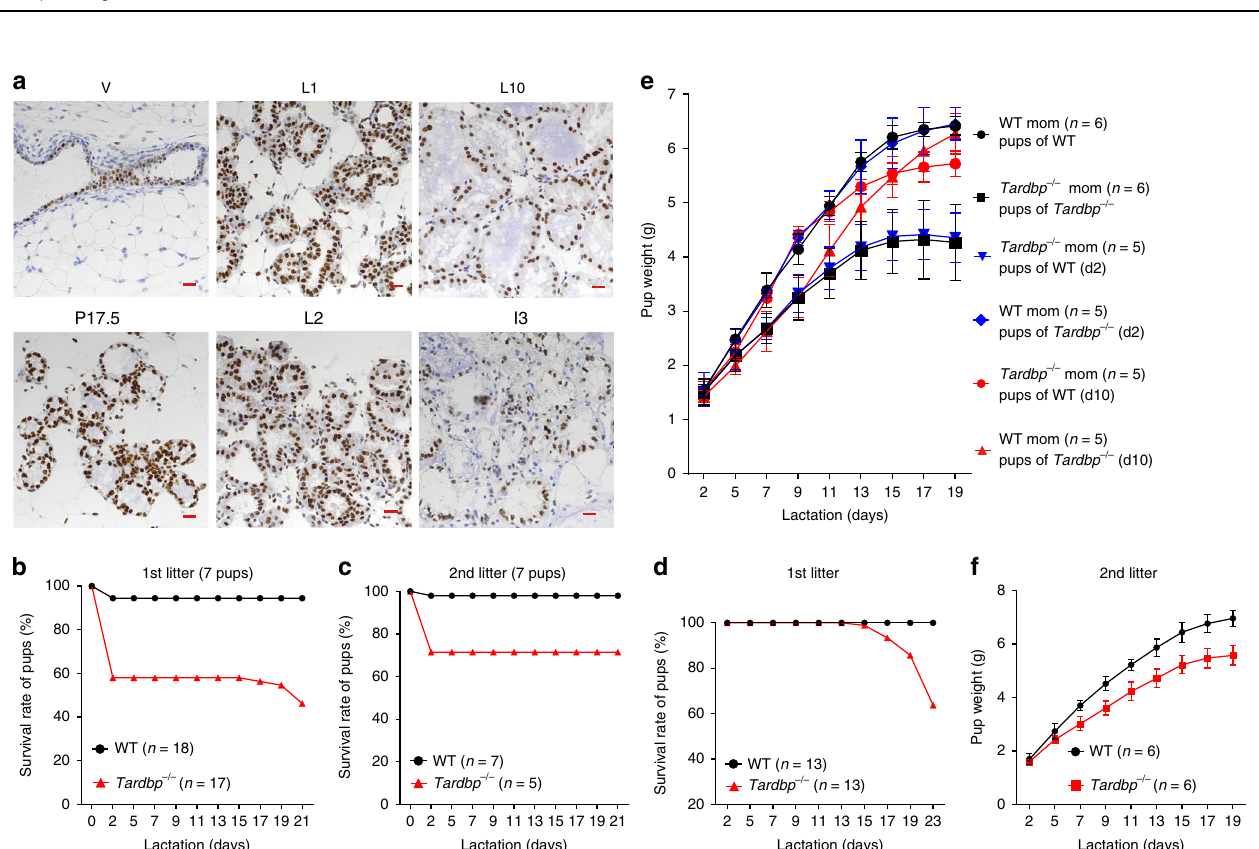
Fig. 1 TDP-43 loss induces lactation failure in mammary epithelium. a Immunohistochemical (IHC) staining of TDP-43 in mammary glands of C57BL/6 female mice at different developmental stages (V, virgin; P17.5, pregnancy day 17.5; L1, lactation day 1; L2, lactation day 2; L10, lactation day 10; I3, involution day 3). Representative images (×40 objective magni fi cation) from four mice are shown for each stage. Scale bar: 20 μ m. b , c Pup survival rates from wild-type (WT) and Tardbp − / − female mice for fi rst ( b ) and second ( c ) lactation, with seven pups per litter. WT represents Tardbp wt/wt + WAP-Cre mice. Tardbp − / − represents Tardbp fl / fl + WAP-Cre mice. n represents number of mothers. d Pup survival rates from WT and Tardbp − / − mothers after litter size was adjusted to seven for each foster mother on L2. e Body weights of surviving pups from WT and Tardbp − / − mothers. Pups nursed by their biological mother (WT or Tardbp − / − , black lines) and cross-nursed by their foster mother ( Tardbp − / − or WT) at L2 (blue lines) and L10 (red lines) were recorded for each dam with seven pups beginning at L2. f Body weights of pups from second lactation after litter size was adjusted to seven on L2. Data are means ± SD. Source data are provided as a Source Data fi le. exclude possible defects in pups, pups born to WT and Tardbp − / − these results demonstrate that maternal Tardbp − / − induced mothers were cross-fostered by Tardbp − / − and WT mothers, failure of both pup viability and growth. respectively. Results demonstrated that pups born to Tardbp − / − female mice but fostered by WT mice beginning at L2 grew with TDP-43 loss results in disrupted lipid secretion . Morphological normal body weights and survival rates, whereas pups born to WT changes were fi rst evaluated to determine the possible causes of females but fostered by Tardbp − / − mice exhibited reduced growth lactation defects in Tardbp KO mice. Mammary glands from (Fig. 1e, blue lines and Supplementary Fig. 5I). A similar reduction Tardbp − / − mice harvested at the mid-pregnancy (P15.5, P17.5) in body weight was observed when pups born to WT females were to lactation stages (L2 and L10) demonstrated no differences in fostered by Tardbp − / − females at the beginning of L10 (Fig. 1e, either lobuloalveolar structures or alveolar densities compared red lines). These results indicate that TDP-43 is required for with WT mice based on whole-mount (Supplementary Fig. 6A) lactation to support offspring survival in mice. To ensure that the and hematoxylin and eosin (H&E) staining (Supplementary observed failure of offspring growth and viability was dependent Fig. 6B). Moreover, TUNEL assay and Ki67 staining revealed on the Tardbp genotype of the mothers, rather than that of the indistinguishable rates of apoptosis and proliferation at P17.5 pups themselves, we genotyped all deceased pups and found (Supplementary Fig. 6C – F). These results suggest that pup deaths normal genotype distribution (Supplementary Fig. 5J). Overall, were unlikely due to structural defects caused by Tardbp KO.